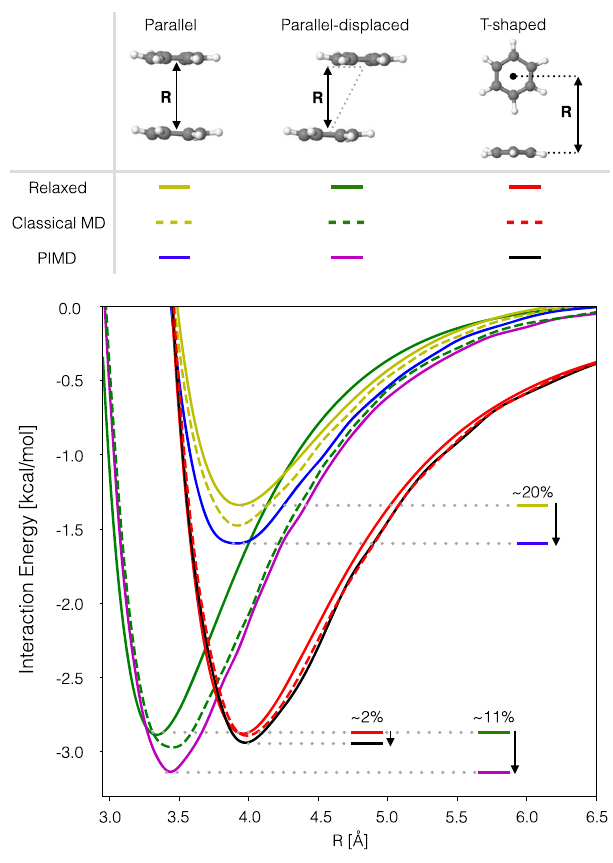
Fig. 5 Strengthening of noncovalent interactions in benzene dimer by NQE. Interaction energy calculations scan along the inter-molecular distance R for the parallel, parallel-displaced and T-shaped con fi gurations of the benzene dimer. Each of these curves was calculated for the relaxed con fi gurations and for con fi gurations sampled from classical MD and PIMD trajectories of single benzene molecule. The total noncovalent interaction energies were computed using SAPT0/jul-cc-pVDZ 31 as implemented in Psi4 package 32 . The molecular con fi gurations were sampled from classical MD and PIMD trajectories computed using i-PI software coupled with the sGDML@CCSD(T) force fi eld. See Supplementary Note 8 for more